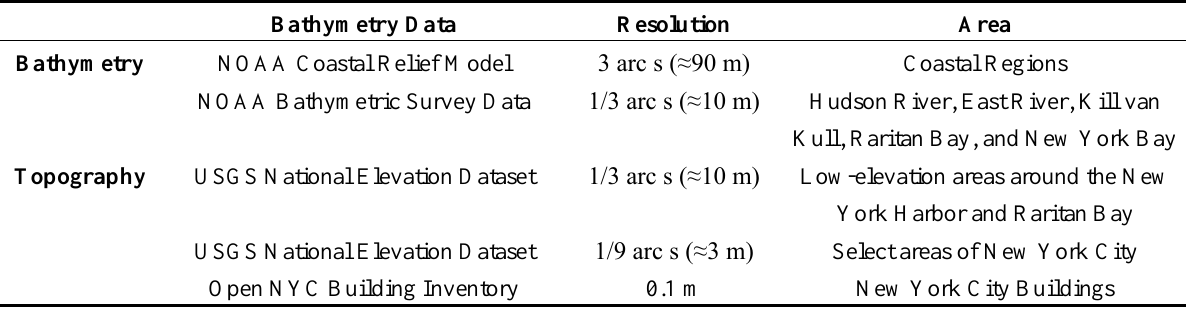
Table 1. Data sources of the bathymetry and LIDAR topography used as inputs in the